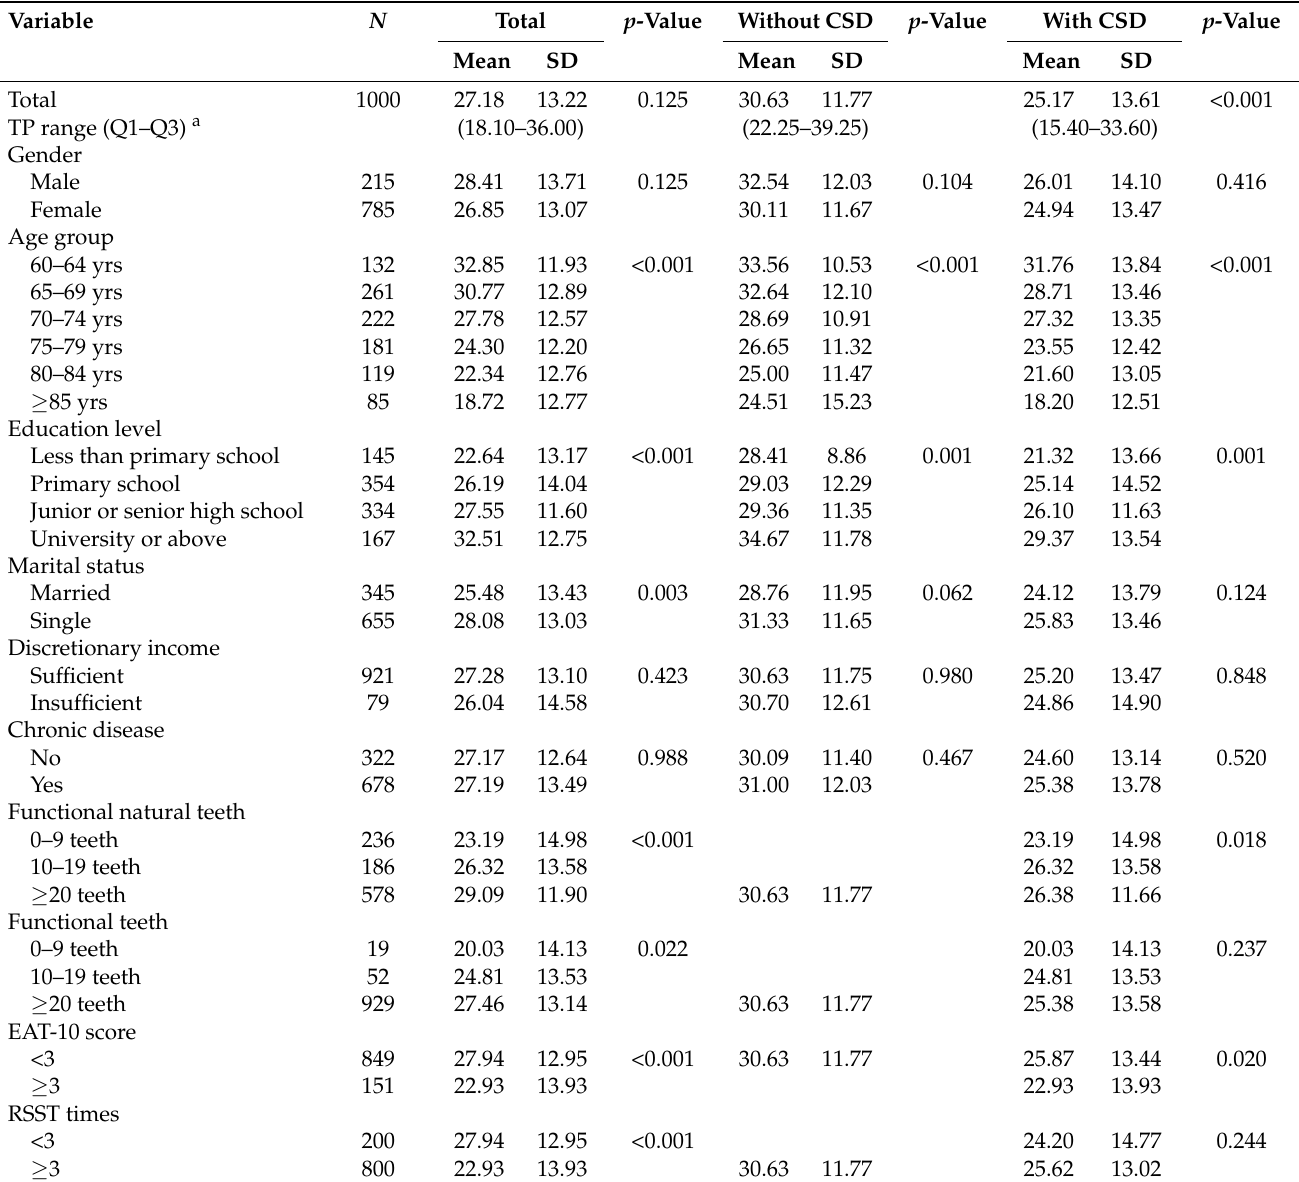
Table 2. Tongue pressure of participants.